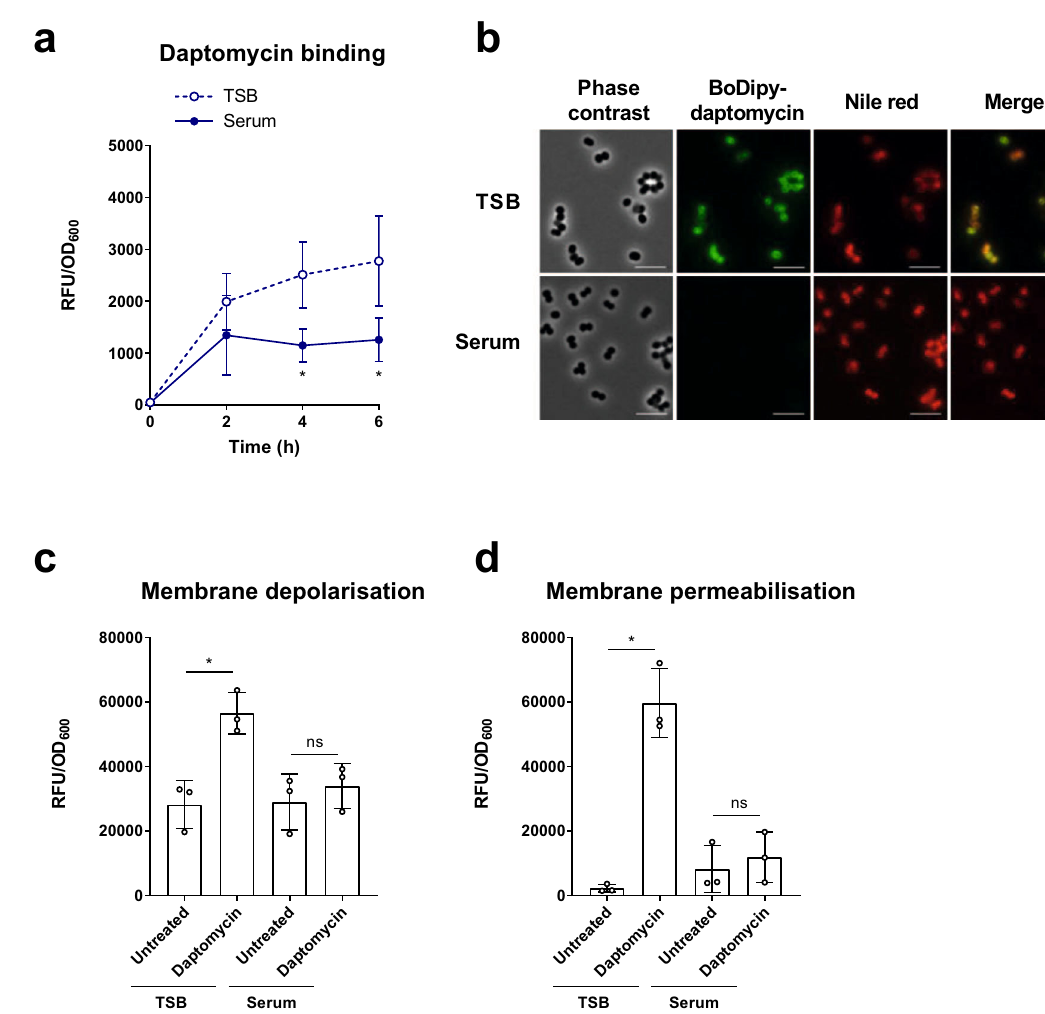
Fig. 2 Daptomycin does not bind to or disrupt the membranes of S. aureus incubated in serum. Cell-associated fl uorescence of TSB-grown and serum- adapted cultures of S. aureus USA300 WT over a 6 h incubation with 320 µ g ml − 1 BoDipy-daptomycin ( a ). Cells after 2 h daptomycin exposure from panel ( a ) were fi xed and analysed by phase contrast and fl uorescence microscopy ( b ). Cells were co-stained with 10 µ g ml − 1 nile red to visualise cell membranes. Scale bars, 5 µ m. DiSC 3 (5) ( c ) and propidium iodide ( d ) fl uorescence of TSB-grown and serum-adapted cultures after 6 h exposure, or not, to 80 µ g ml − 1 daptomycin in serum. Fluorescence values were divided by OD 600 measurements to normalise for changes in cell density which occurred throughout the assays. Graphs represent the mean ± standard deviation of three independent experiments (NS = not signi fi cant ( P > 0.05). *For ( a ), P = 0.0276 (4 h), 0.0132 (6 h). For ( c ), P = 0.0033 and ( d ), P < 0.0001). Data in ( a ) were analysed by two-way ANOVA with Sidak ’ s post-hoc test (TSB-grown vs serum- adapted at each time-point). Data in ( c ) and ( d ) were analysed by two-way ANOVA with Tukey ’ s post-hoc test (untreated vs daptomycin-exposed). TSB, tryptic soy broth; RFU, relative fl uorescence units; OD 600 , optical density at 600 nm. Source data are provided as a Source Data fi